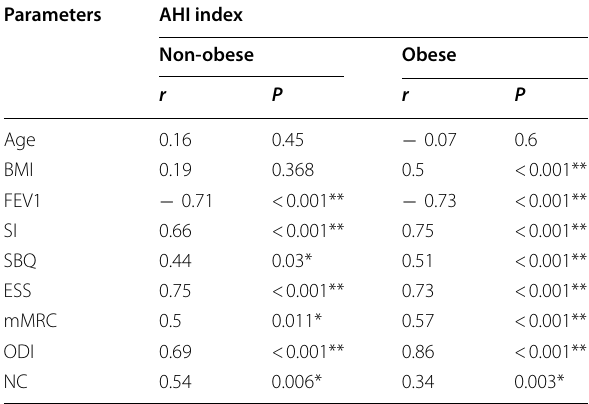
Table 6 Correlations between AHI index and certain studied parameters within each